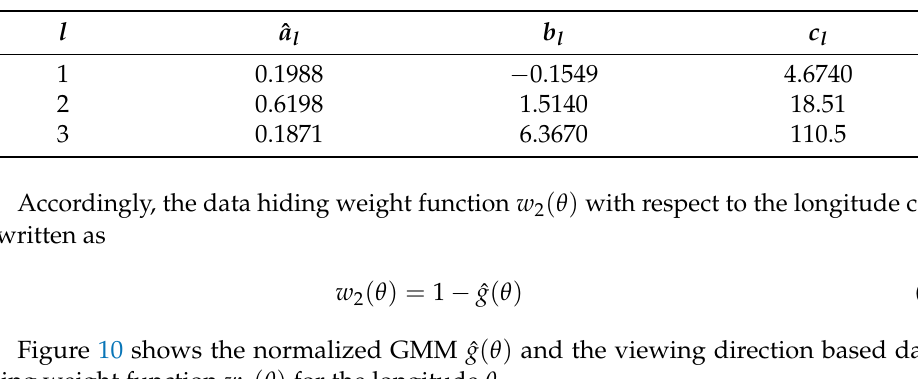
Table 2. Parameters of the normalized GMM ˆ g ( θ ) for longitude θ